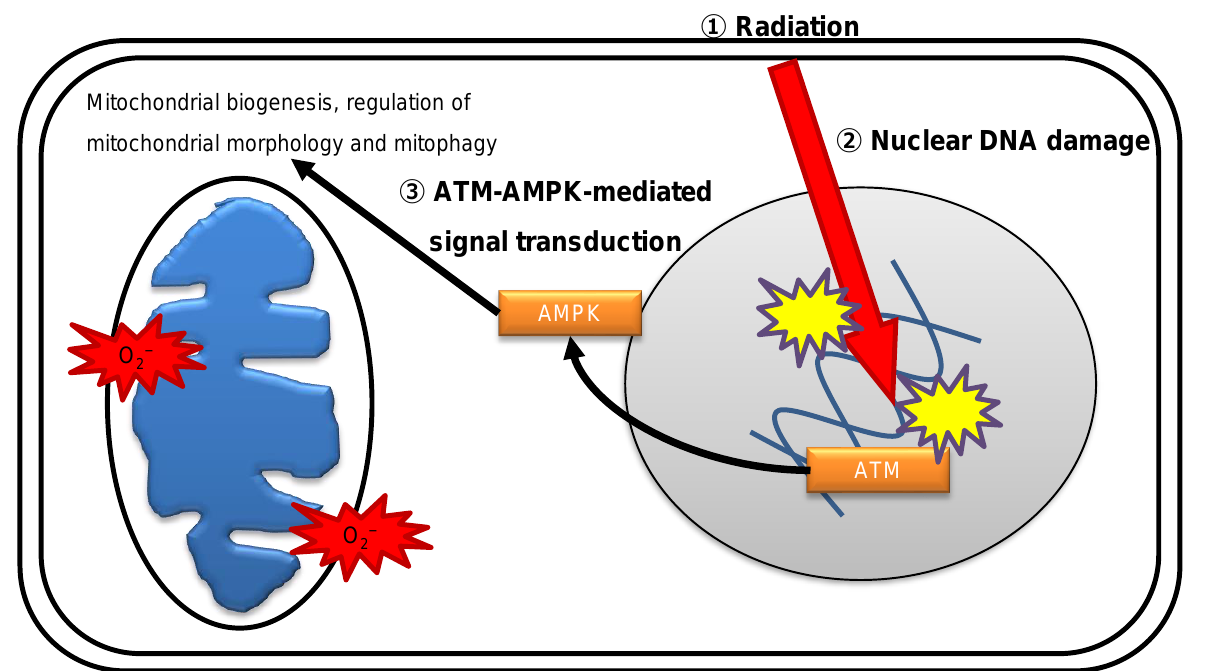
Figure 2. ATM-mediated crosstalk between the nuclei and